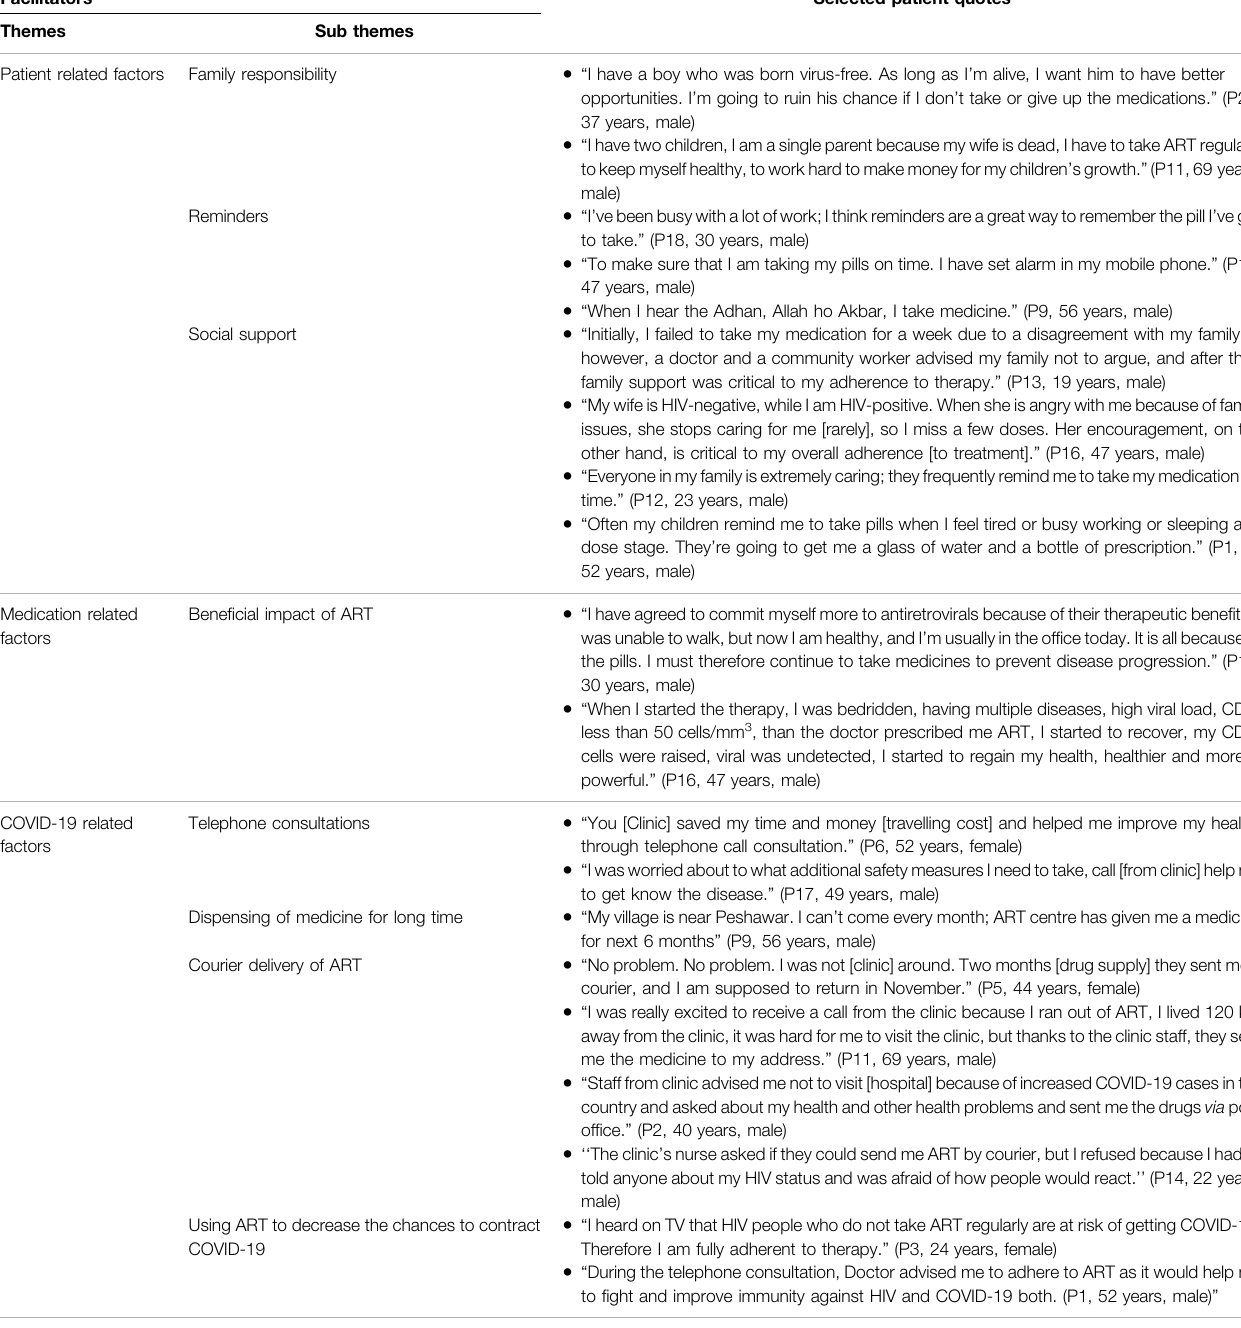
TABLE 3 | Facilitators to retention in HIV care for people living with HIV in